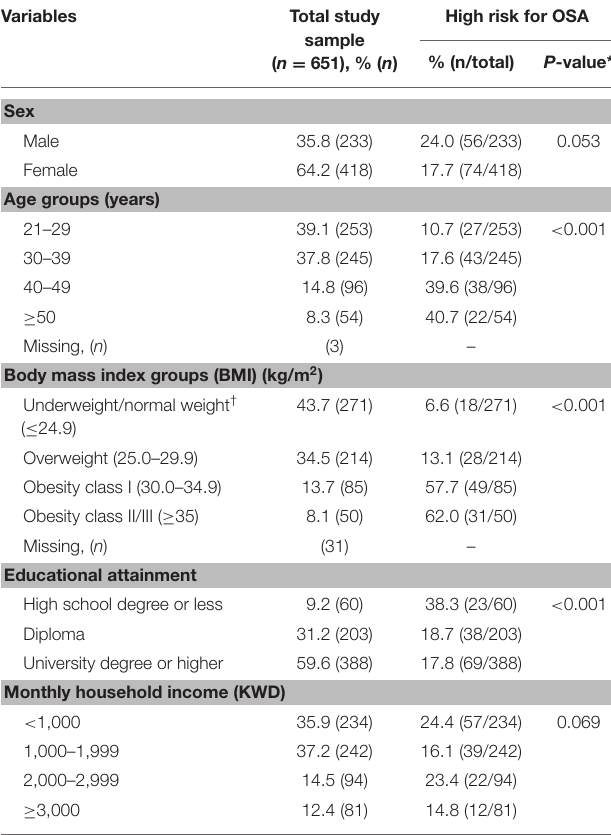
TABLE 1 | Characteristics of study participants in the total study sample and according to the risk of obstructive sleep apnea (OSA).